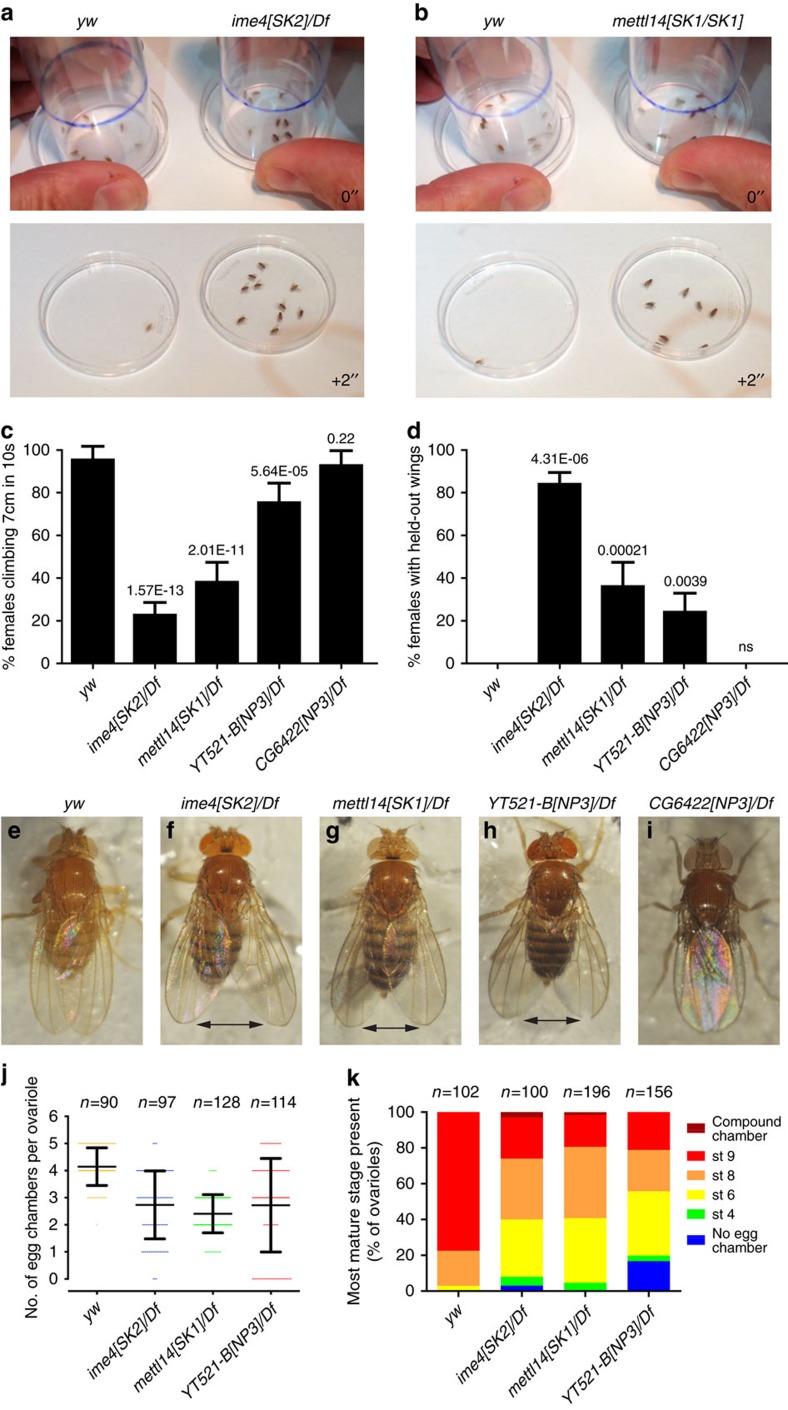
Behavioural defects in m6A pathway mutants.Adult female flies were analysed in these figures. (a,b) Flight defects. 10 flies were tapped down into a petri plate and their movement once the arena was opened was observed; selected video stills are shown. Most control yw flies jump up and/or fly away immediately, or within a couple of seconds. In contrast, ime4 (a) and mettl14 (b) mutants mostly remain in the plate. (c) Negative geotaxis assay. A total of 10 flies were placed in an empty vial and tapped to the bottom, and their ability to climb was quantified. Five independent cohorts of flies per genotype were assays, and the assay was done in triplicate for each group of flies. Nearly all control (yw) flies cross a 7 cm mark within 10 s; indeed, nearly all of these reached this mark in <5 s. Most ime4 hemizygotes stayed at the bottom of the vial, and a minority slowly climb to the designated height. mettl14 and YT521-B homozygous and/or hemizygous mutants also display strongly reduced negative geotaxis, whereas CG6422 mutants were not affected. Similar behavioural defects were observed in male mutants (see Supplementary Fig. 9). (d) Wing postures of adult flies. The frequency of flies that exhibit held-out wings, and are unable to maintain them in a normal folded position across the back. Statistics in (c,d) are from one-way ANOVA, Tukey's Multiple Comparison Test analysis. (e) yw adult fly illustrates the normal folded position, while ime4 (f), mettl14 (g) and YT521-B (h) hemizygotes all show mildly held-out wings (as marked by the double arrows); CG6422 mutant (i) is unaffected. (j) Quantification of egg-chamber number shows that different m6A pathway mutant ovaries exhibit fewer than in yw control. (k) Distribution of egg chamber stages shows a skew towards early stages in m6A pathway mutants relative to yw control.